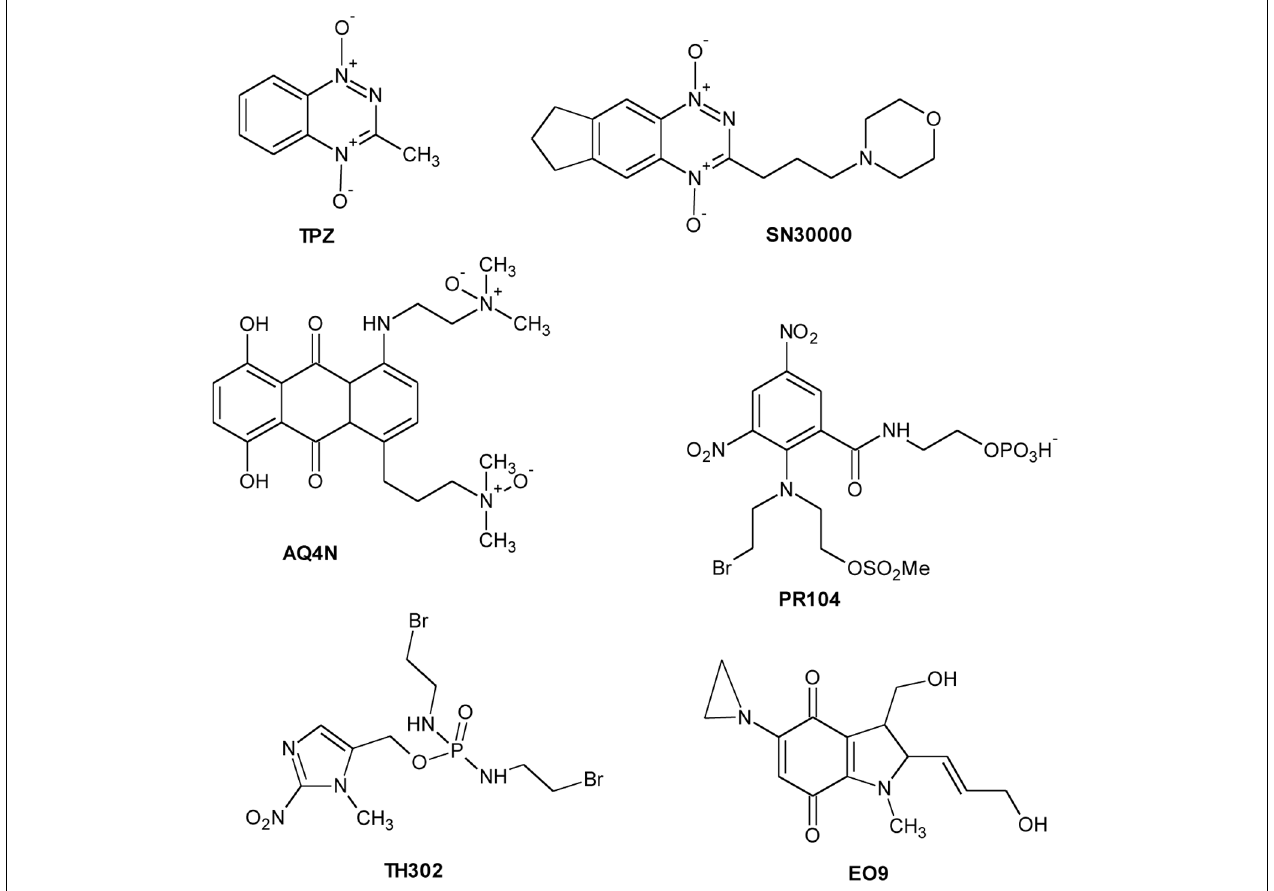
Chart 3 | Hypoxia Activated Prodrugs